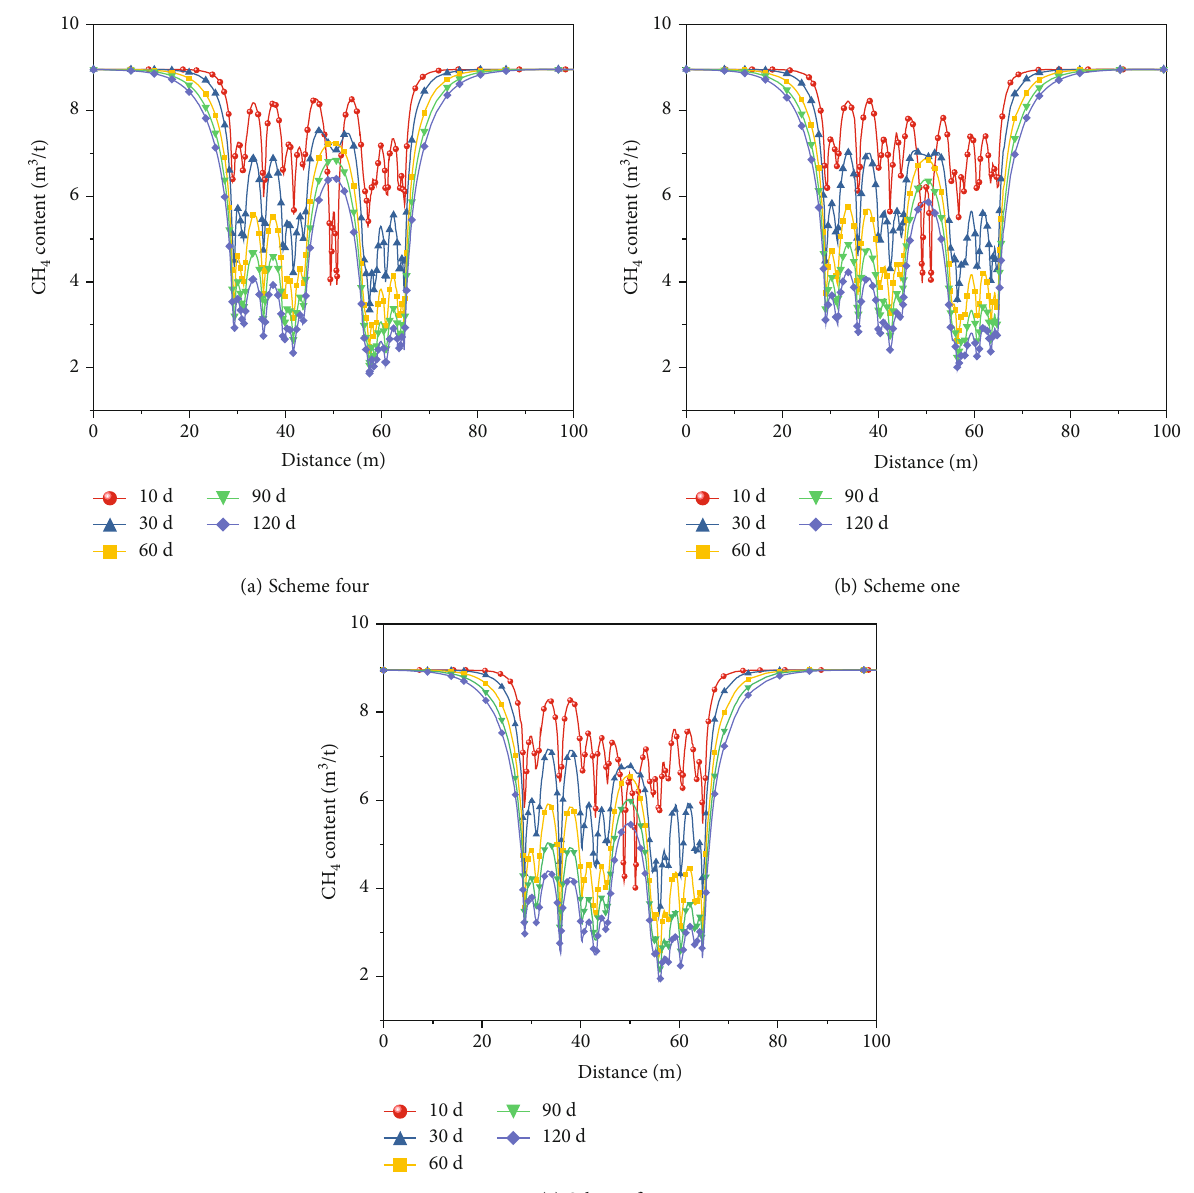
Figure 4: Evolution curve of gas content on reference line A-B under di ff erent borehole